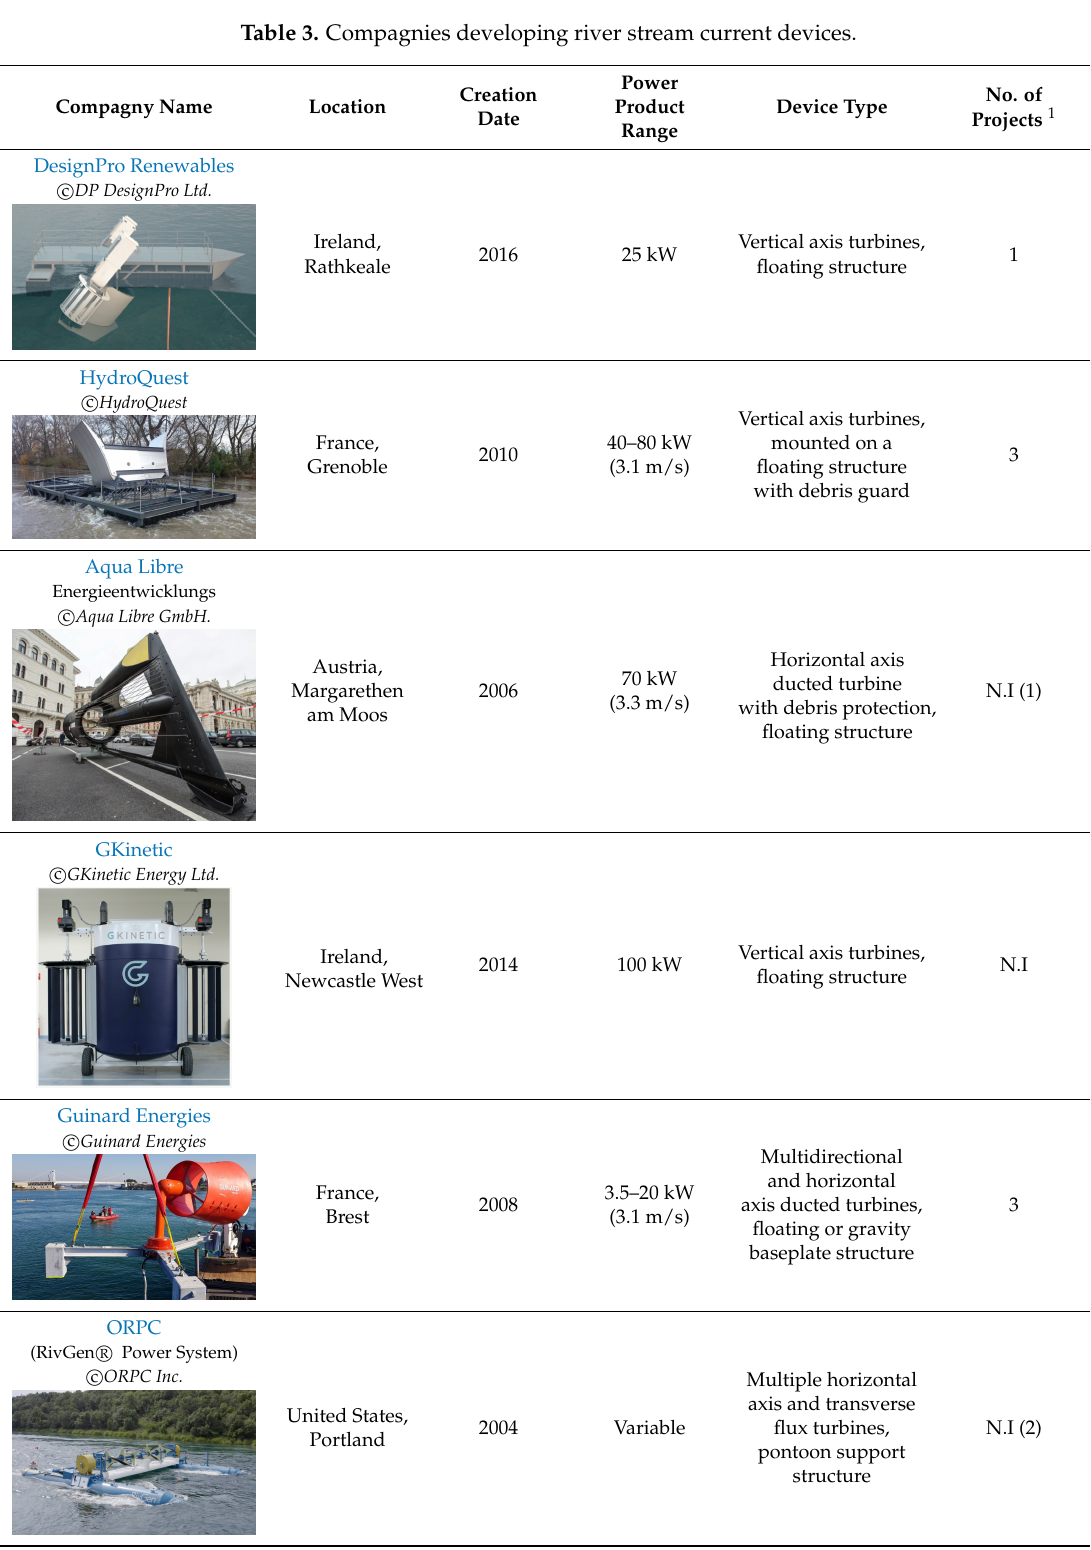
Table 3. Compagnies developing river stream current